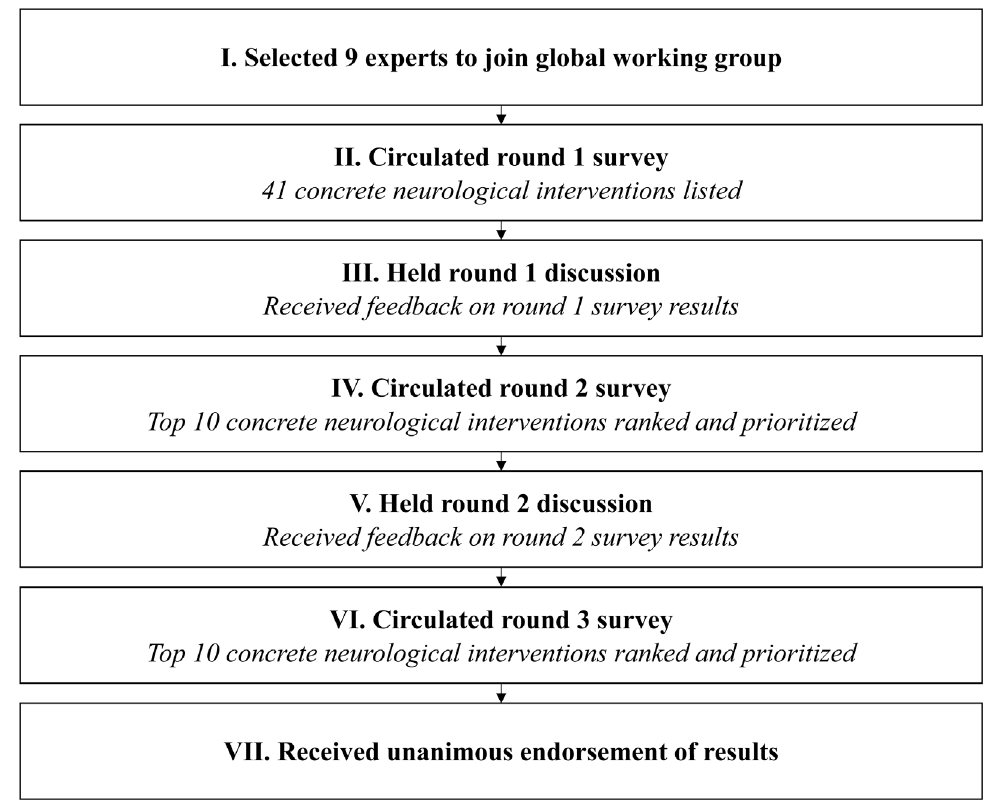
Figure 1. Delphi method